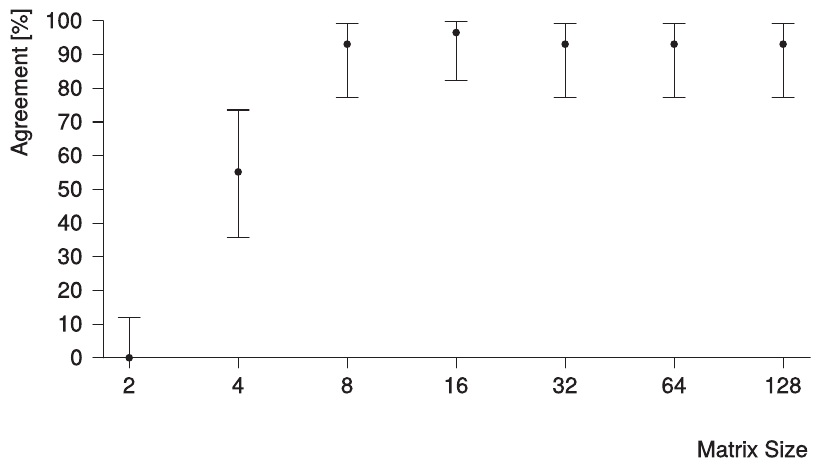
Fig. 5. Agreement of the phase number provided by the findLV algorithm with the reference phases identified by the two readers for each matrix size investigated. The numbers on the x-axis represent the number of voxels in both the x- and y-direction of the image. The number of voxels in z-direction depends on the original image, but the same shrink factor was used for all three dimensions. 95% CIs are displayed as error bars. The readers could choose multiple phases and the intersection of both was the reference for the algorithm. The matrix size of 16 6 16 resulted in the highest agreement with a value of 97% (95% CI: 82–